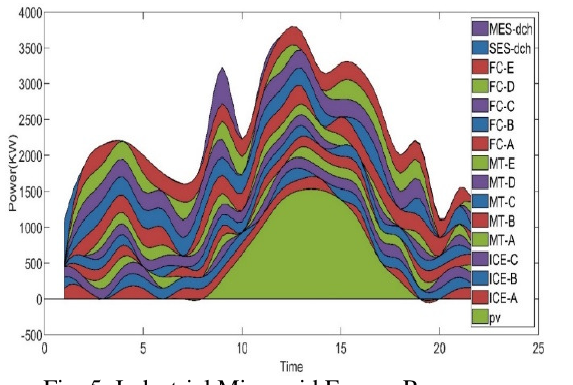
Fig. 5: Industrial Microgrid Energy Resources